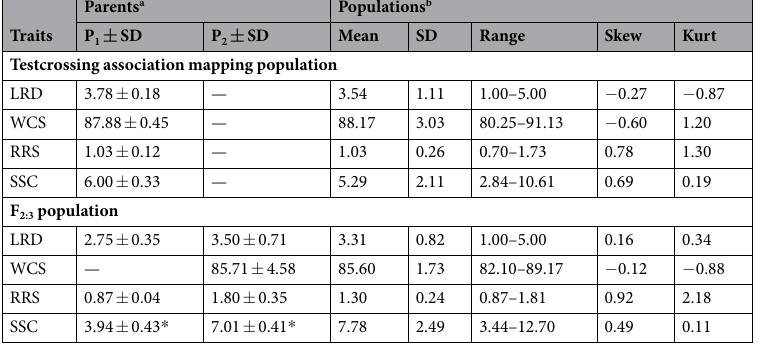
Table 1. Performance of leaf roll degree (LRD), water content of shoots and leaves (WCS), ratio of root- to-shoot (RRS), and soluble sugar content (SSC) in the testcrossing association mapping panel and the F 2:3 population. a P 1 in the testcrossing association mapping population is S-Mo17; P 1 and P 2 in the F 2:3 population are K932 and Mei C, respectively; “—”means the data is missing; SD = standard deviation; * represents the difference between the two parents is significant at the level of p < 0.05. b Skew = skewness, Kurt =